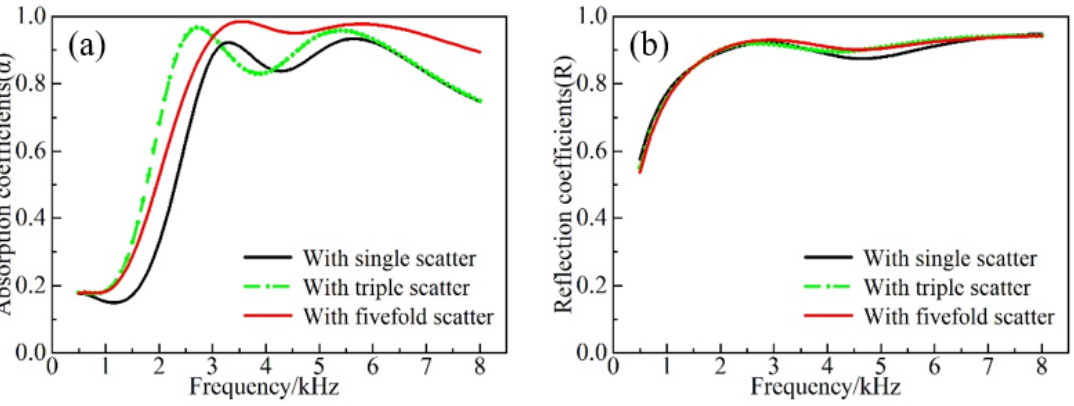
Figure 9. ( a ) Forward absorption and ( b ) backward reflection with different numbers of scatterers.